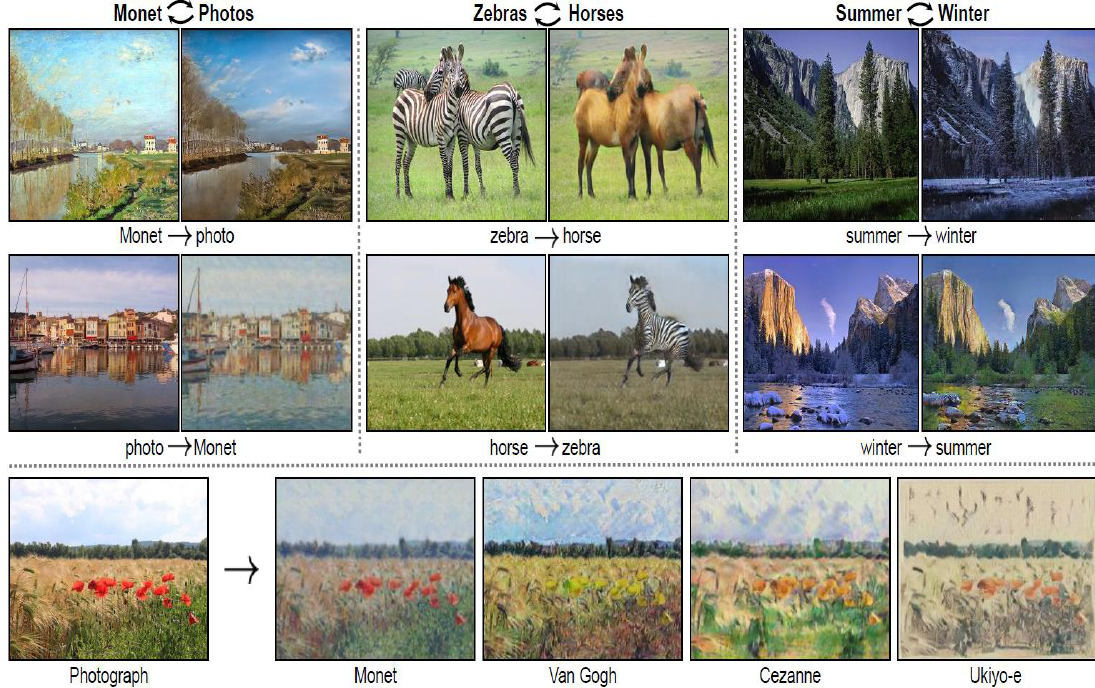
Figure 5. Surface normal map-to-natural scene mapping example.